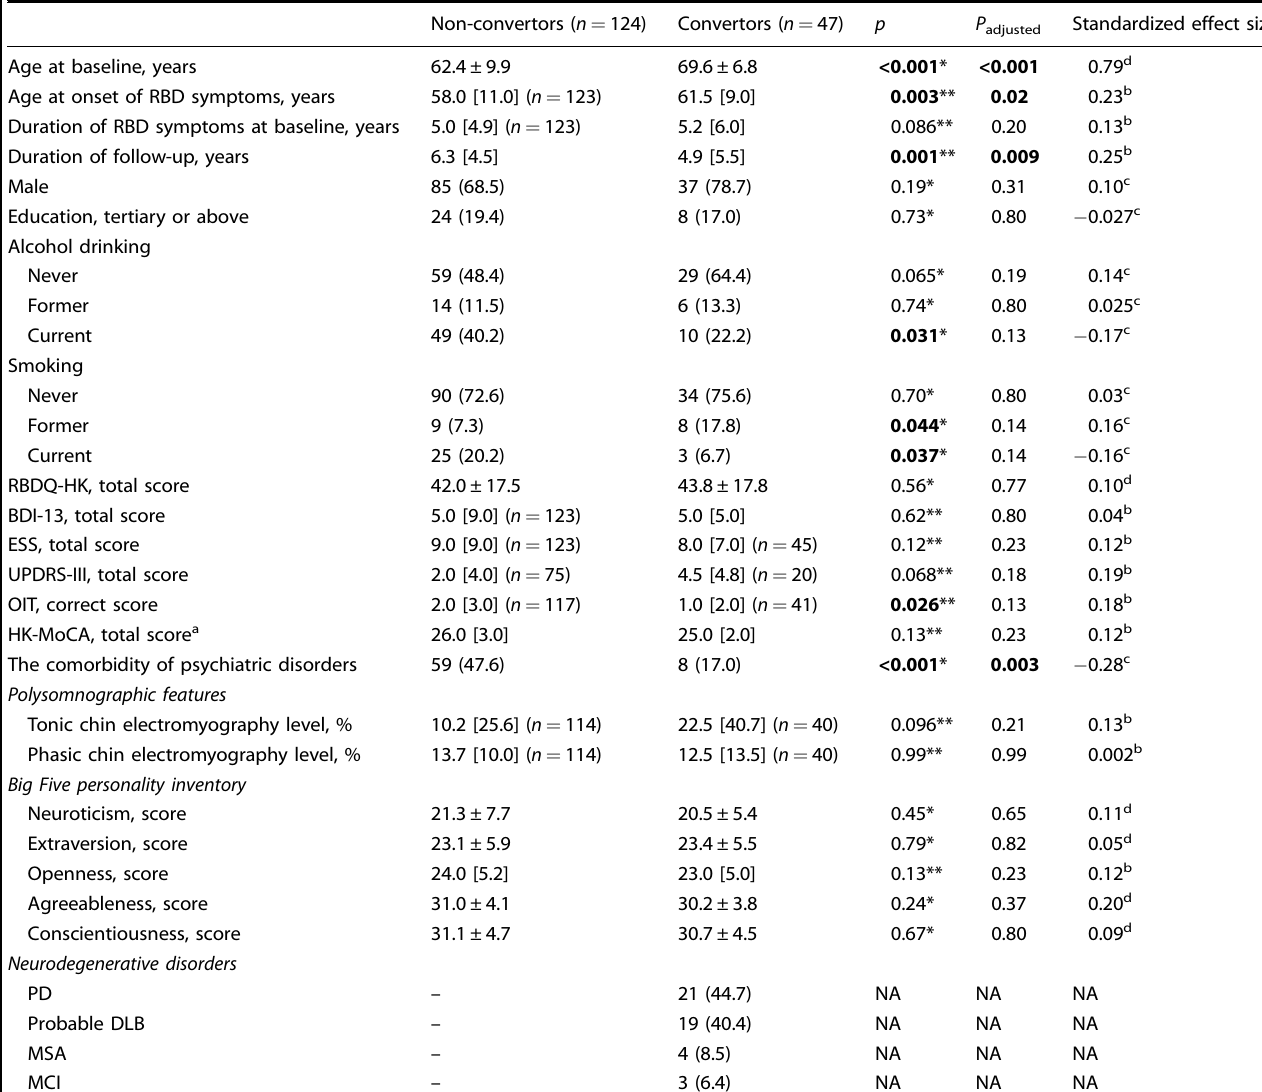
Table 3. Demographics, neurodegenerative biomarkers, and personality traits between non-convertors and convertors at